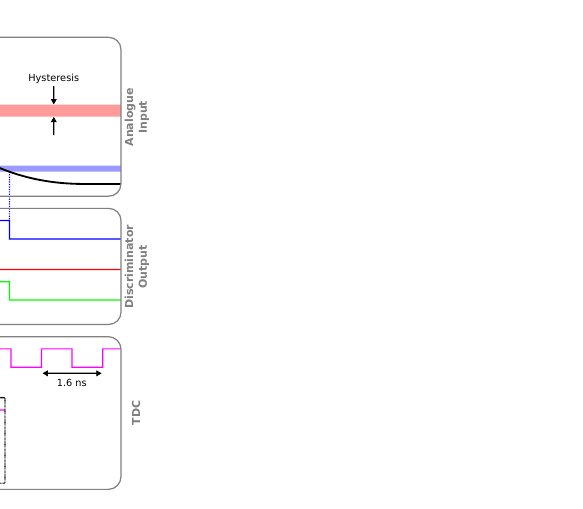
Figure 14. Sketch of the M U TR I G chip functionality. The time and energy information of the analogue signal is obtained via two discriminator units, whose output is processed by a TDC with a 625 MHz coarse counter and a fine counter with a 50 ps beam size